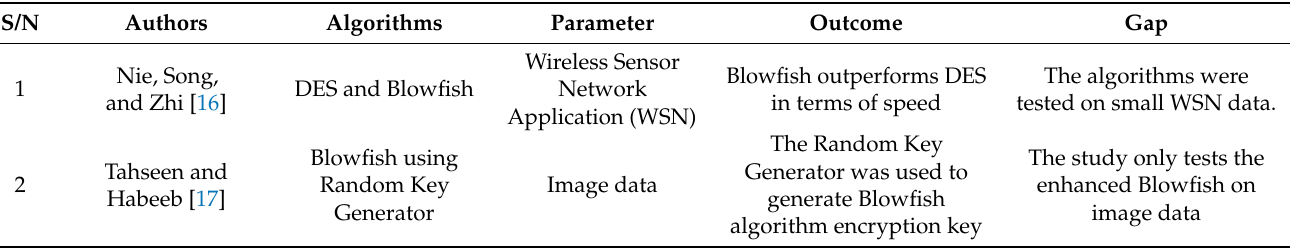
Table 1. Summary of Literature